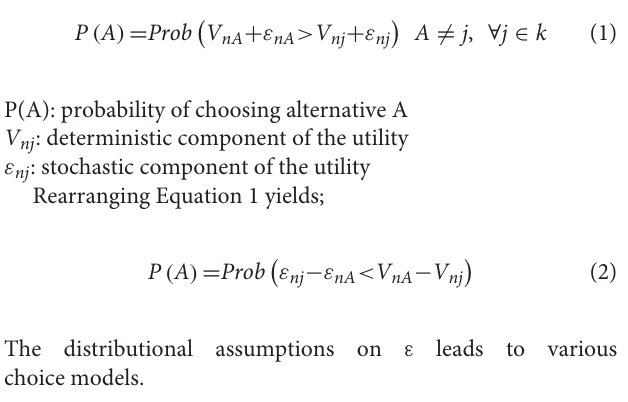
TABLE 3 | Choice experiment variable coding. Independent variables Units and coding of the variable Vaccine attributes